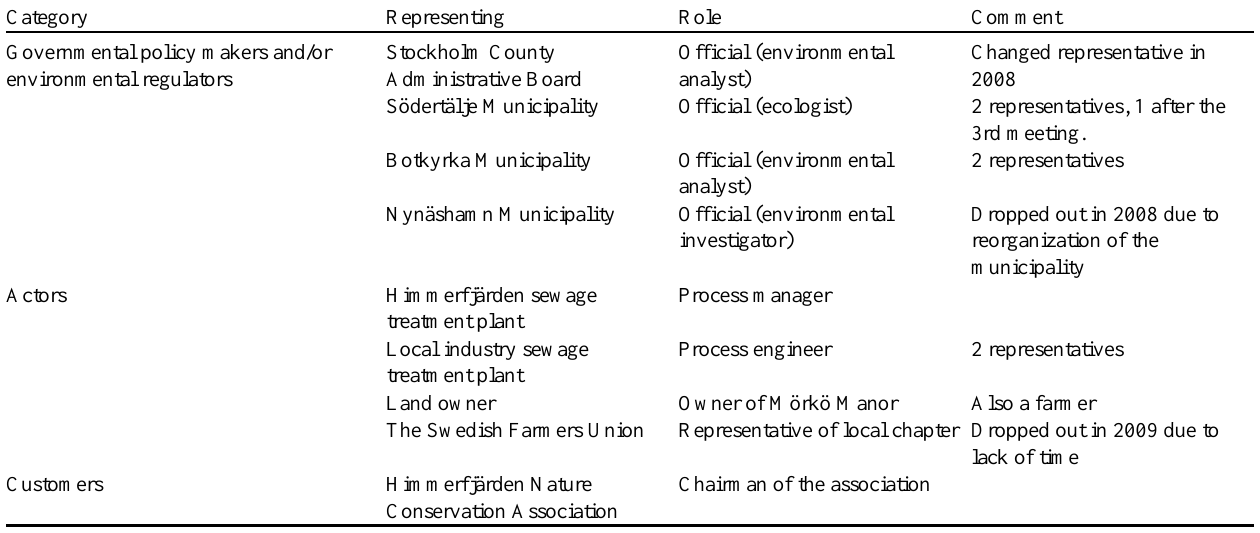
Table 3 . Stakeholder group